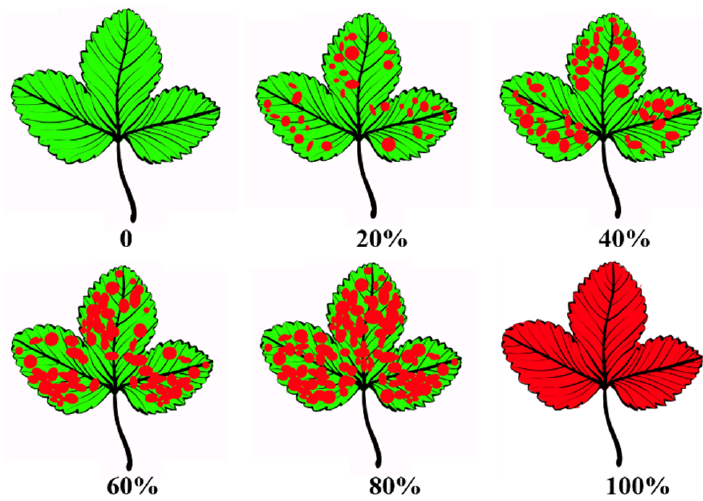
Figure 12. Standard area diagrams for powdery mildew severity on strawberry leaves.